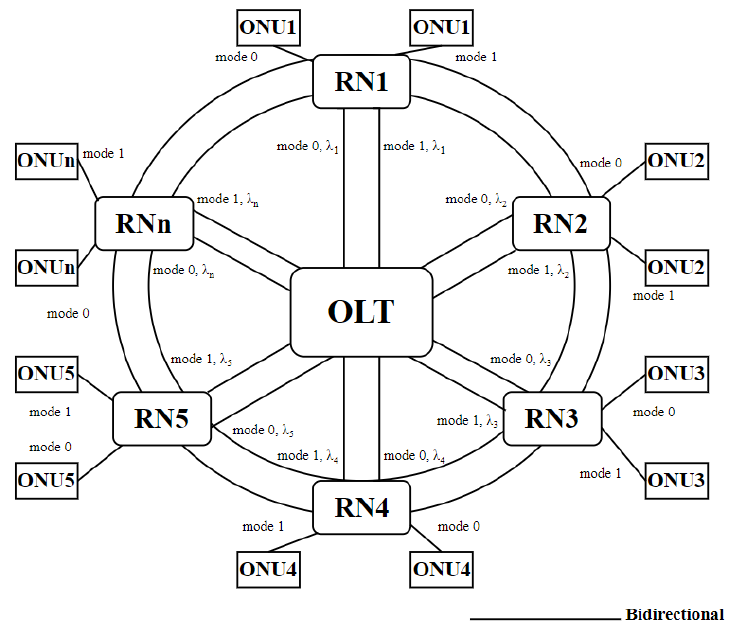
Figure 1. Conceptual diagram of network resilience wheel-based hybrid MDM-OCDMA-PON using modes 0 and 1.